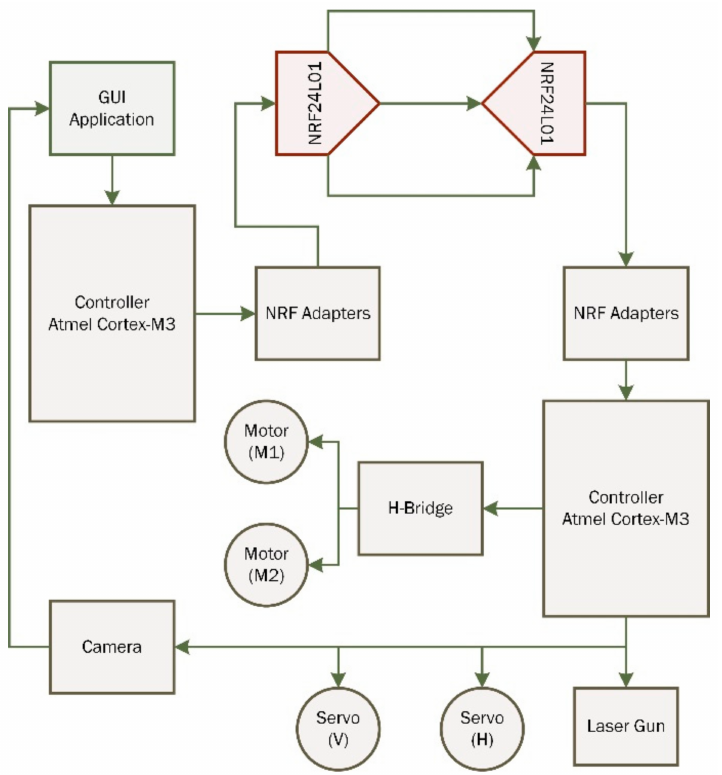
Figure 10. Electronic